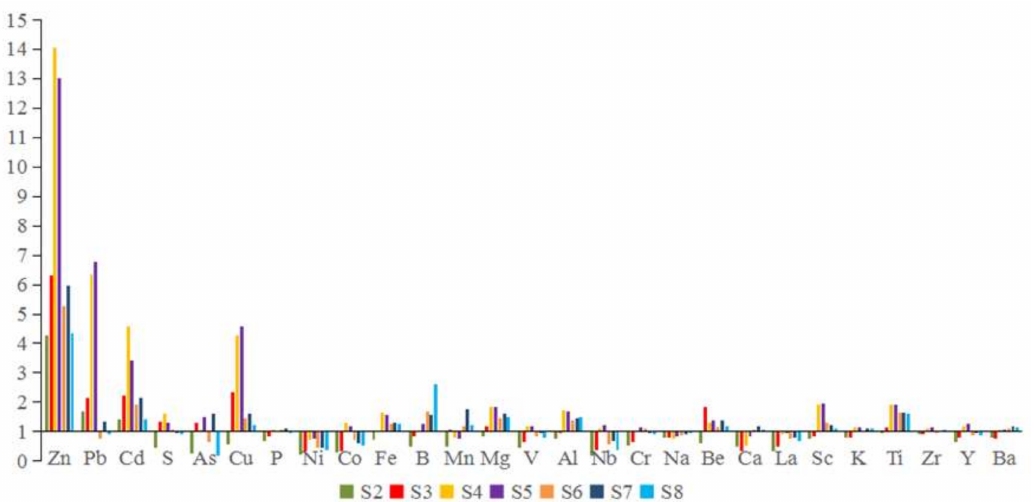
Figure 4. The Af values of the metals in the sediment